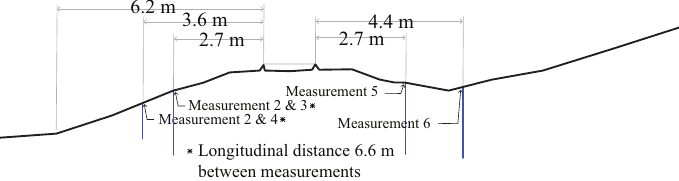
Figure 9. Positions of the Panda tests at the km137 point across a cross-section of the